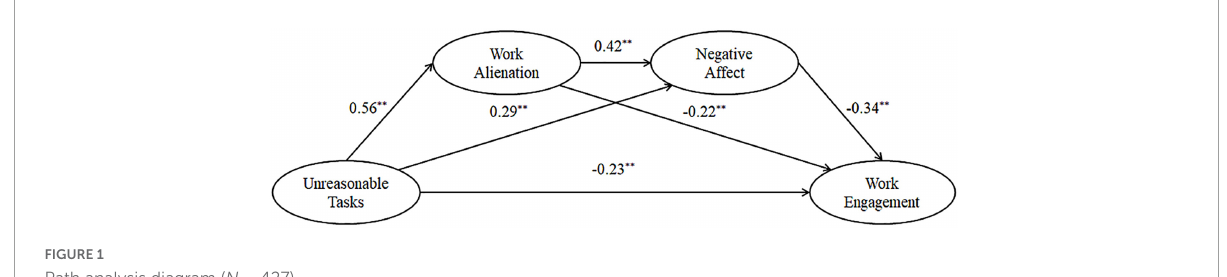
FIGURE1 Path analysis diagram ( N = 427).